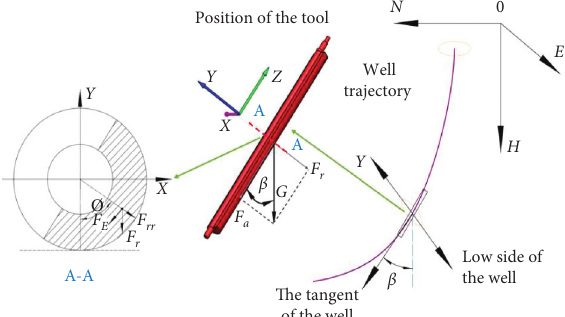
Figure 2: Schematic diagram of restoring force calculation of gravity block.